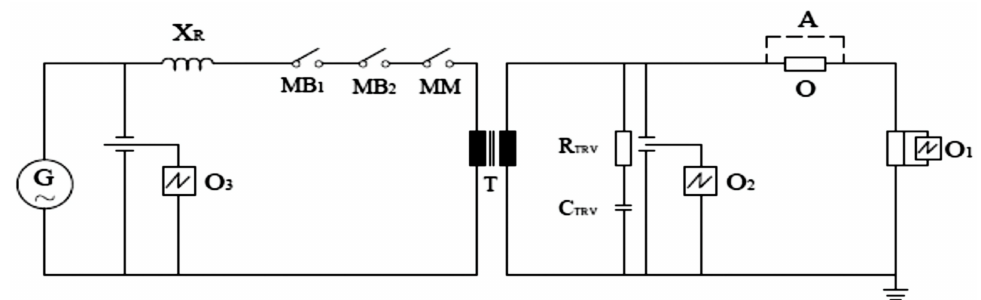
Figure 1. Test circuit for test series I 1 and I 2